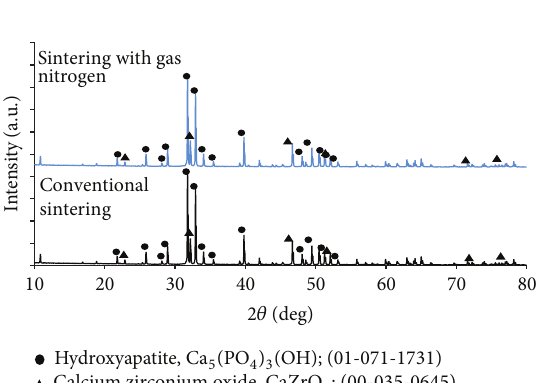
Figure 1: TEM micrograph of HA powder.